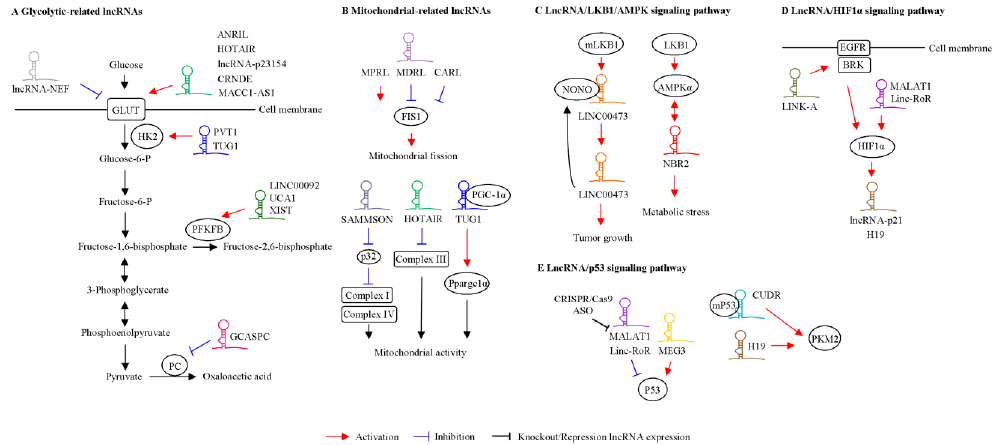
Figure 2. Functional roles of lncRNA in tumor metabolism. LncRNAs regulate target gene-mediated glucose metabolism ( A ) and mitochondrial function ( B ) in cancer. The role of lncRNA-mediated liver kinase B1 (LKB1)/AMP-activated protein kinase (AMPK) pathways ( C ), hypoxia-inducible factor 1α (HIF1α) ( D ), and p53 ( E ) in tumor cells was shown.